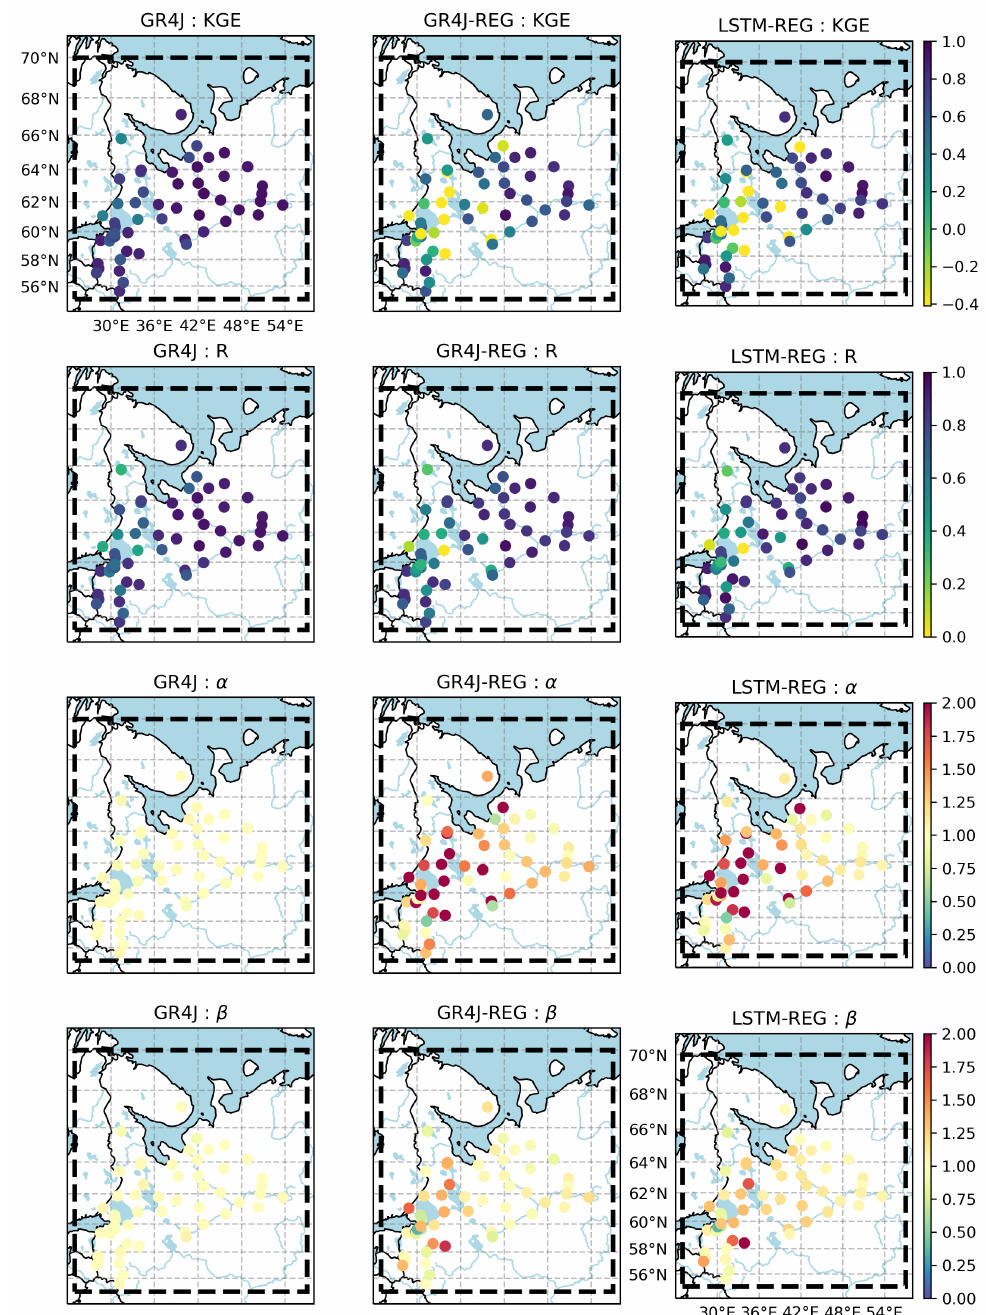
Figure 10. Performance evaluation results of GR4J-REG and LSTM-REG gridded runoff datasets in comparison with the results of GR4J basin-scale calibration in terms of the Kling–Gupta efficiency and its components: correlation R, variability α , and bias β . The results are presented in maps that show a spatial distribution of the respective evaluation